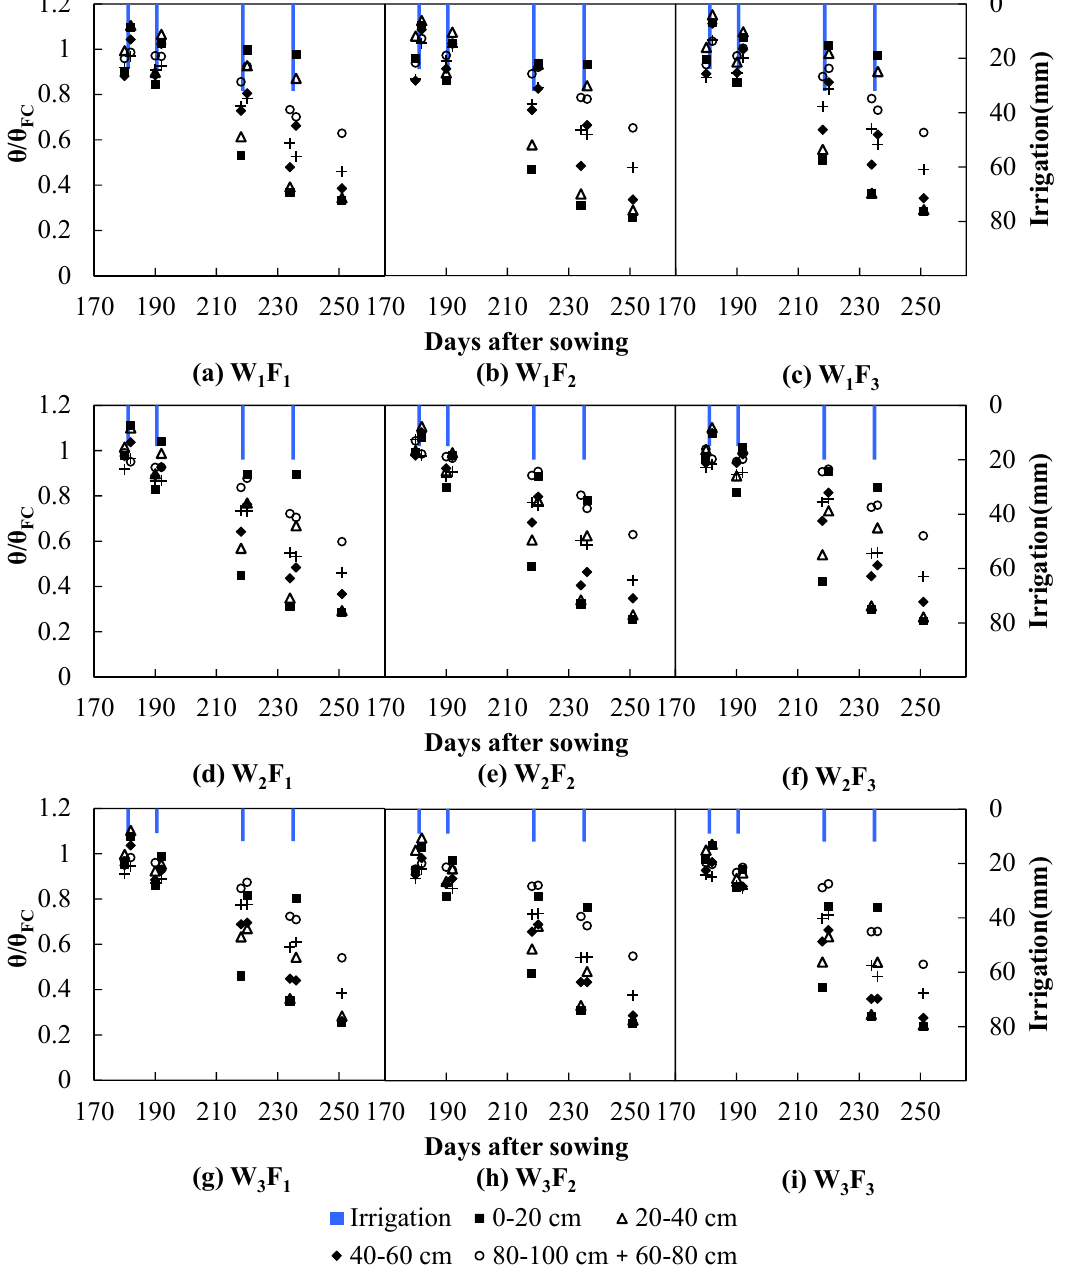
Figure 2. Temporal variation in relative soil moisture ( θ / θ FC ) during the 2012 winter wheat growing season for nine treatments; W 1 , W 2 and W 3 : irrigations scheduled according to 0.8, 0.5 and 0.3 cumulative evaporation of 20-cm-diameter pan (E); F 1 : N application at 120 kg·ha − 1 , F 2 : N application at 140 kg·ha − 1 and F 3 : N application at 190 kg·ha − 1